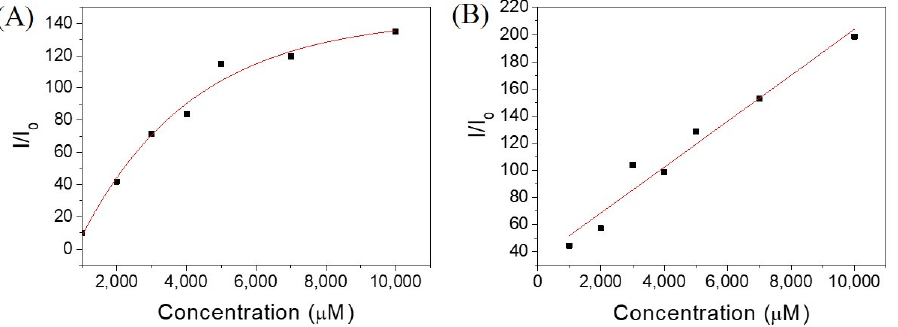
Figure 5. Emission intensities of ThT at various concentrations of hydrogelators of ( A ) Ben-IKVAV and ( B ) PFB-IKVAV . (I 0 : without adding hydrogelators.).